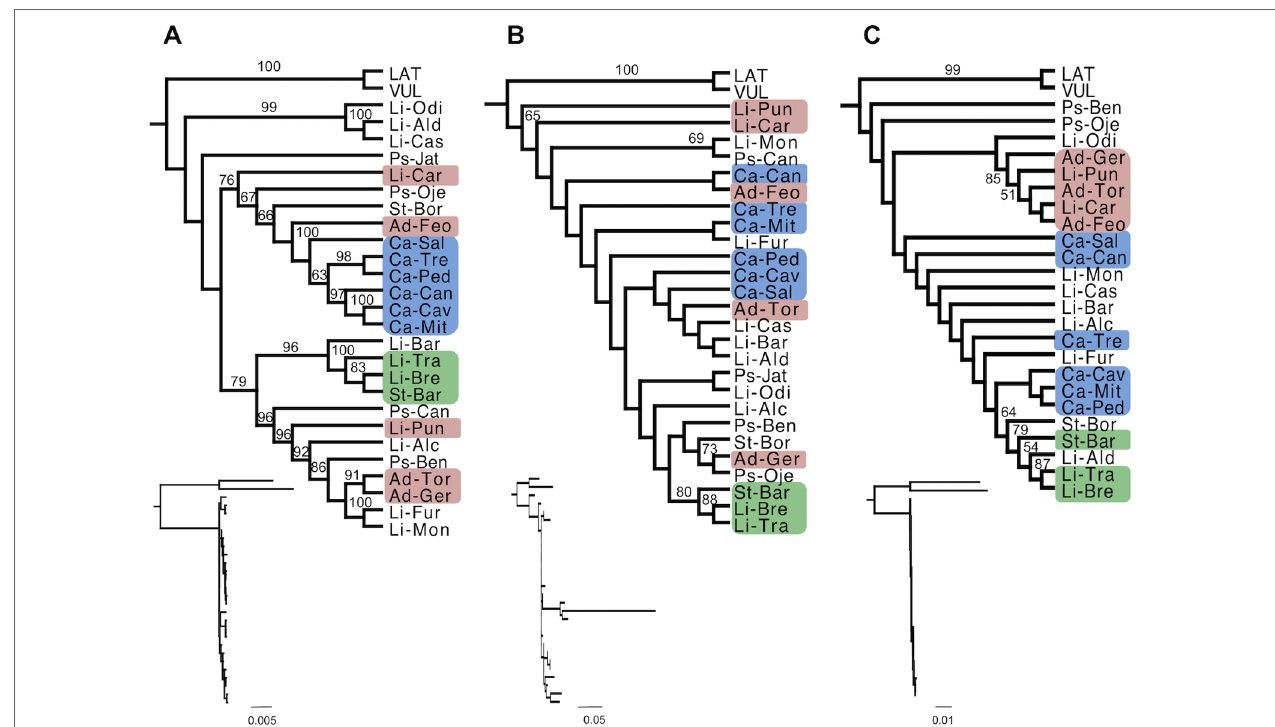
FIgURe 3 | Phylogenetic relationships within the Section Psammophilae using maximum likelihood (ML) estimation. Phylogenetic relationships were determined from the complete chloroplast genomes (a) , six coding regions of the mitochondrial genome (B) , and complete nuclear ribosomal cistron with a partial ETS (c) . Sequences were aligned, rooted with two outgroups, and analyzes under maximum likelihood (ML) phylogenetic methods (RAxML). Numbers above branches represent bootstrap support (BS > 50 are displayed). Cladograms show relationships among taxa, while branch lengths are displayed in the inset phylograms. Branches are drawn proportional to the number of substitutions per site (see scale bar). Blue, green, and red squares represent populations from the Balearic Islands and the southern (Cadiz province) and southeast (Almeria province) of the Iberian Peninsula, respectively. Species and population codes are shown